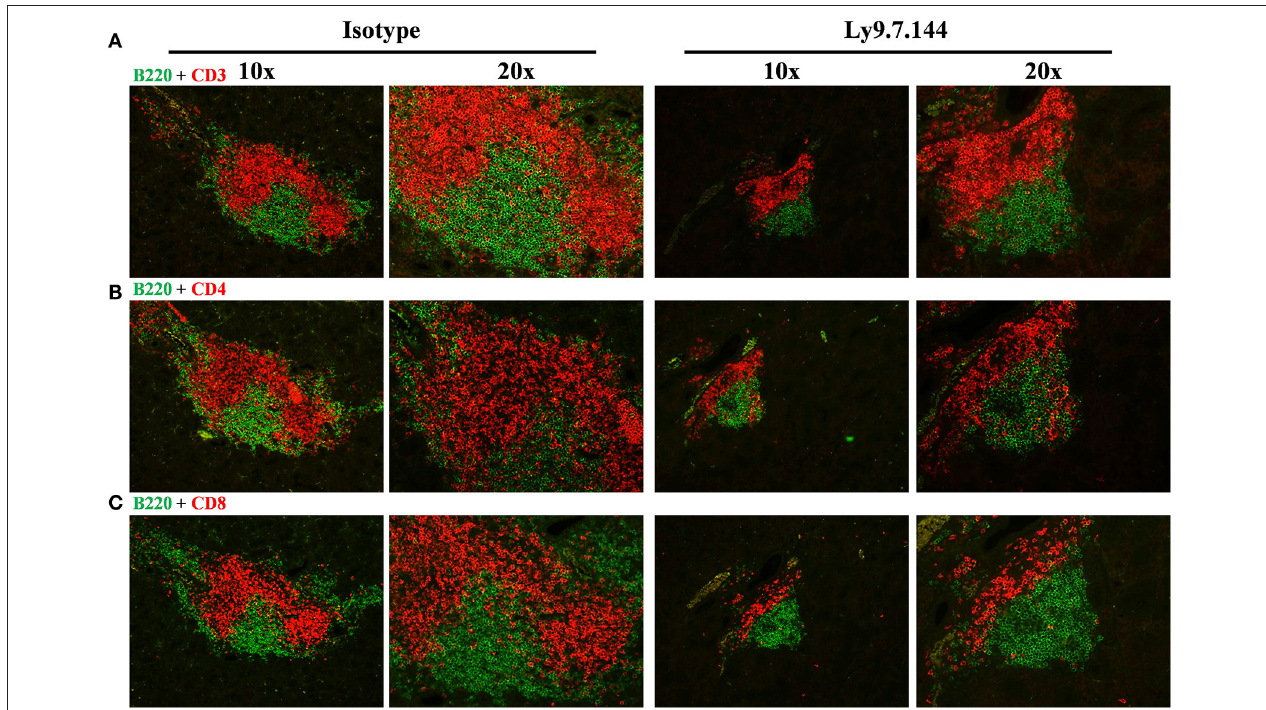
FIGURE 4 | The architecture of salivary gland cell infiltrates is notoriously affected in anti-Ly9-treated SjS mice. Representative immunofluorescence of salivary gland cell infiltrates from anti-Ly9 (right) or isotype control (left) treated NOD.H-2 h4 mice. The following two color colocalizations at 10 × and 20 × augmentations are shown: B220 [green] + CD3 [red] (A) ; B220 [green] + CD4 [red] (B) and B220 [green] + CD8 [red] (C)